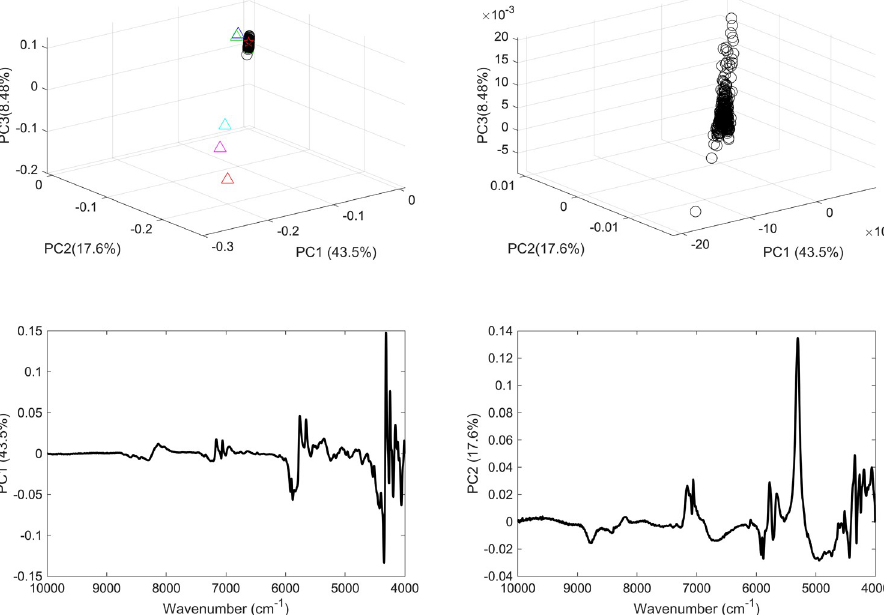
Fig 4. (a) PCA scores plot of COVID-19 vaccine (black circles), mRNA (red star), purified RNA (green and blue stars), normal saline solution (red and green squares) and excipients 1–5 (blue, red, green, cyan and magenta triangles); (b) PCA scores plot of COVID 19 vaccines; (c) PCA loading plot of vaccines and constituents and (d) PCA loading plot of vaccines. The models were applied considering the full wavenumber